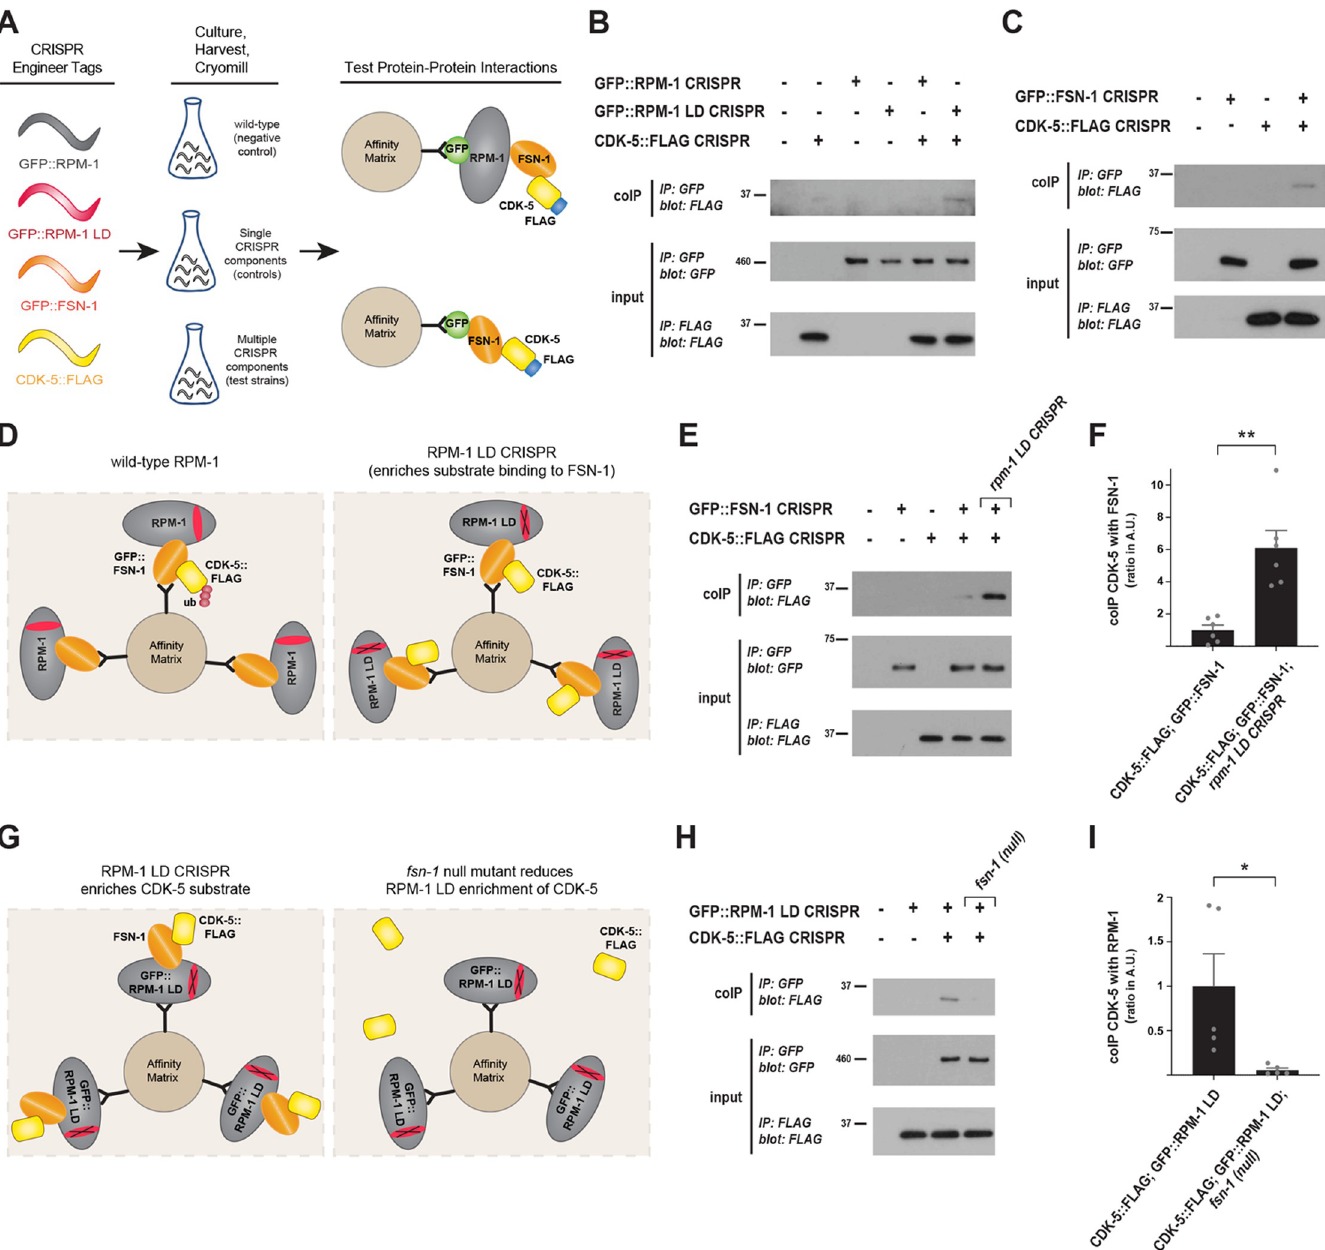
Fig 2. CRISPR-based biochemistry demonstrates substrate-like interactions between CDK-5 and the RPM-1/FSN-1 ubiquitin ligase complex. A ) Schematic of experimental workflow for CRISPR-based, native biochemistry using C . elegans . Multiple rounds of CRISPR/Cas9 engineering was used to affinity tag and point mutate components of the RPM-1/FSN-1 ubiquitin ligase complex and CDK-5. B ) CoIP showing increased binding of CDK-5::FLAG to GFP::RPM-1 LD substrate ‘trap’ compared to GFP::RPM-1. C ) CoIP showing CDK-5::FLAG binds GFP::FSN-1. D ) Schematic showing how rpm-1 LD CRISPR substrate ‘trap’ enriches CDK-5 binding to FSN-1, if CDK-5 is an RPM-1/FSN-1 substrate. E ) CoIP showing increased binding between CDK-5::FLAG and GFP::FSN-1 in rpm-1 LD CRISPR animals (far right lane) compared to wildtype background (second lane from right). F ) Quantification of CDK-5 coIP with FSN-1 in rpm-1 LD CRISPR animals compared to wildtype background. G ) Schematic showing how RPM-1 LD will not bind to CDK-5 in the absence of FSN-1 substrate recognition module ( i . e . fsn-1 null mutant). H ) CoIP showing reduced binding between CDK-5::FLAG and GFP::RPM-1 LD in fsn-1 (null) mutants (far right lane) compared to wildtype background (second lane from right). I ) Quantification of CDK-5 coIP with RPM-1 LD in fsn-1 null mutants compared to wildtype background. For B, C, and E, representative of three or more independent experiments is shown. For H, representative of two independent experiments is shown. For F and I, shown are means from 5–6 replicates from 3 or 2 independent experiments, respectively. Wildtype values were normalized to 1 (Arbitrary Units) to facilitate comparisons. Error bars indicate SEM. Significance assessed using Student’s t -test. �� p < 0.01.